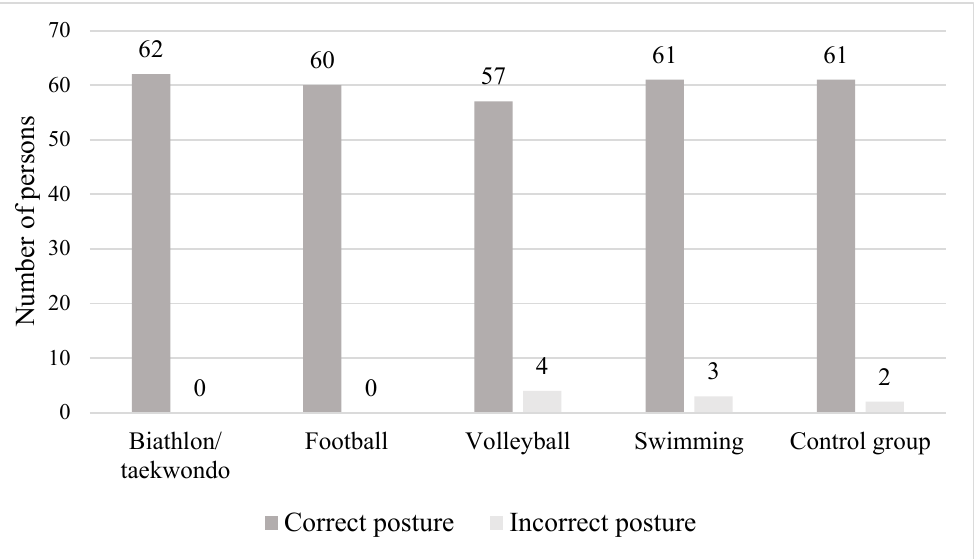
Figure 4. Characteristics of correct and incorrect postures based on the curvature of the spine in the studied groups .